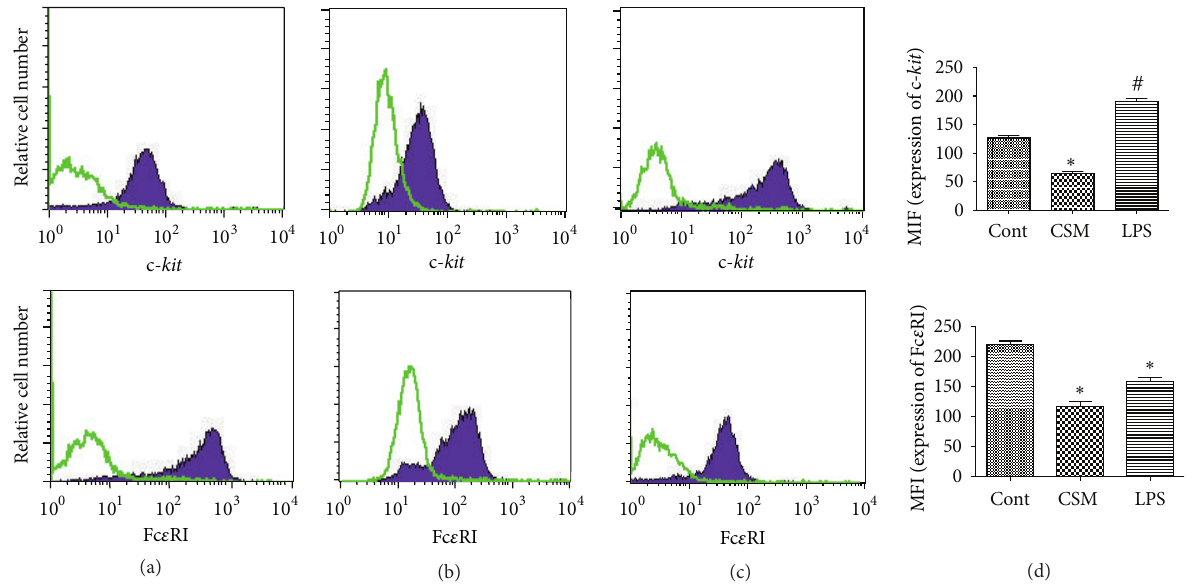
Figure 2: CSM modulates surface expression of Fc 𝜀 RI and c-Kit . BMMCs were cocultured in presence or absence of CSM (1.5%) or LPS during the third week of bone marrow culture. The surface expression of c-kit (upper panels) and Fc 𝜀 RI (lower panels) was detected by flow cytometry (blue histograms): control (a), CSM (b), and LPS (c). Green histograms represent isotype controls. (d) Quantification of 3 representative FACS analyses showing the mean fluorescence intensity (MFI) for each group. Values are expressed as mean ± S.E.M ( 𝑛 = 3 ). ∗, # 𝑃 < 0.05 is significantly different (increased/decreased) compared to control.